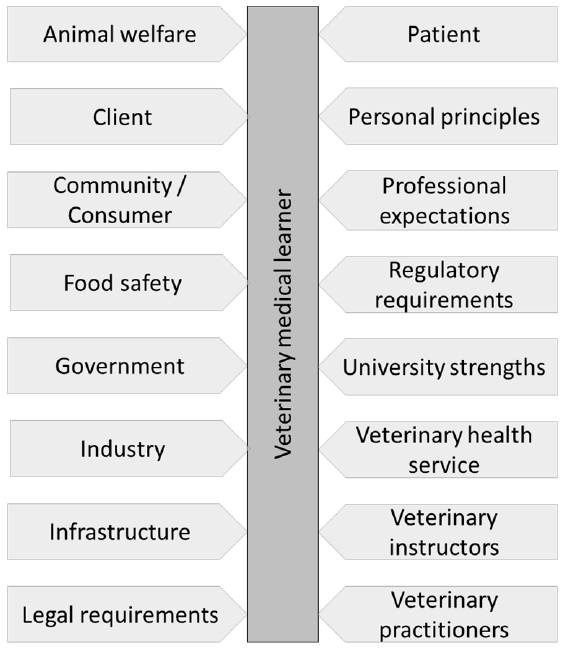
Figure 1. Factors to consider in veterinary clinical education and practice.